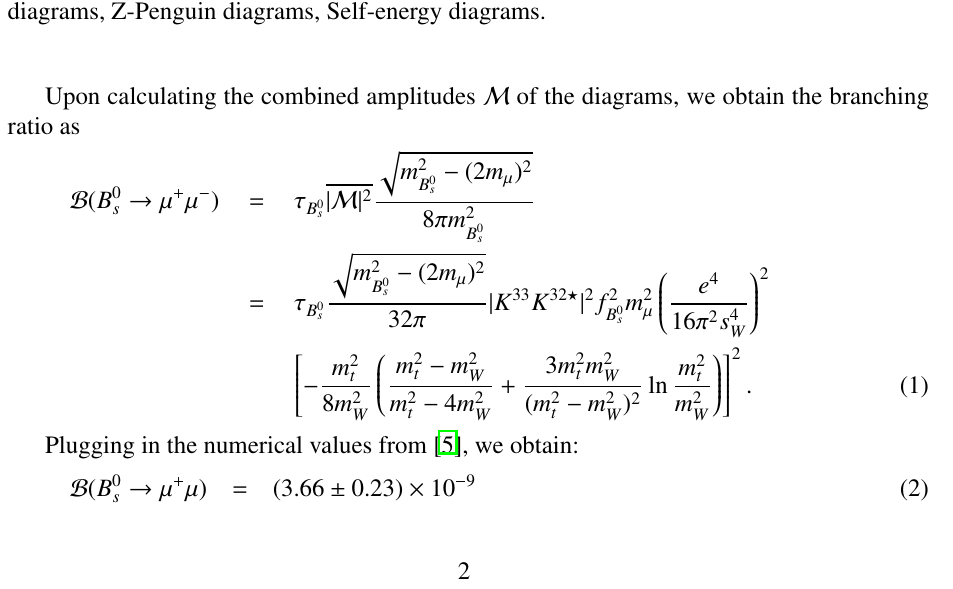
→ µ + µ − within the SM. From left to right: Box s